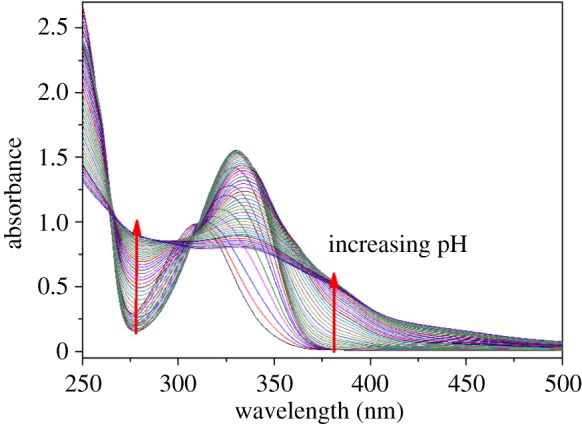
The spectrophotometric titration spectrogram of L1H2, condition: [L1H2] = 5.0 × 10−4 M, µ = 0.10 M KCl, T = 298.2 K, pH range = 5.3–12.5.